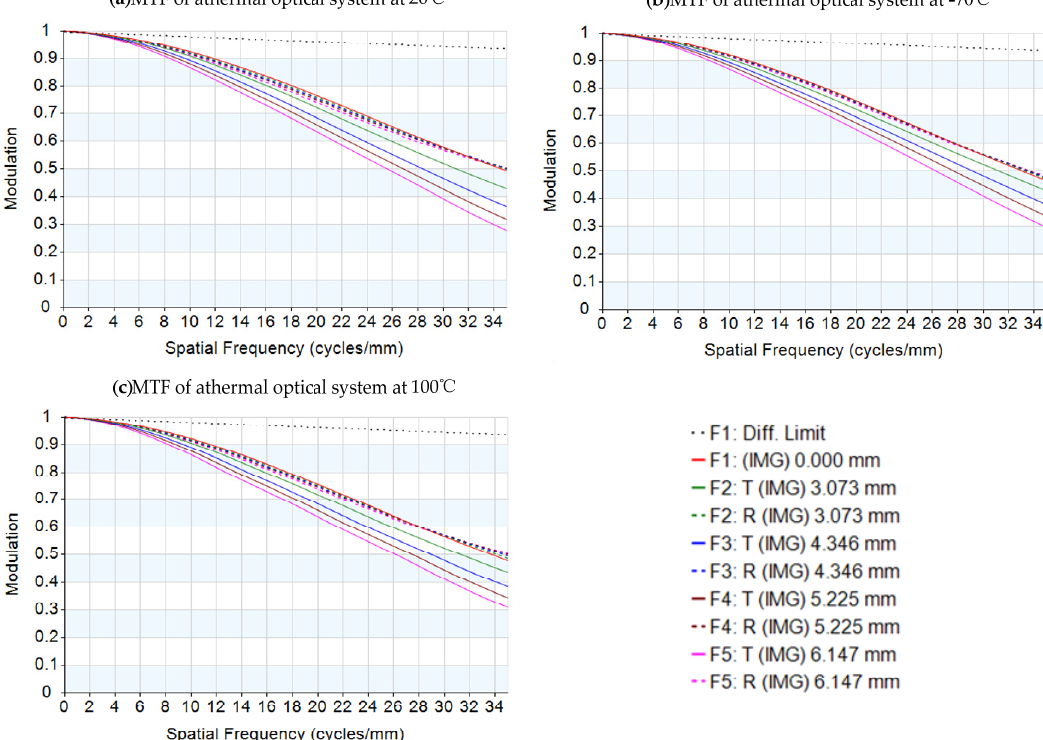
Figure 2. MTF graphs of the passive athermal visible lens with temperatures: ( a ) 20 ◦ C, ( b ) − 70 ◦ C, and ( c ) 100 ◦ C.